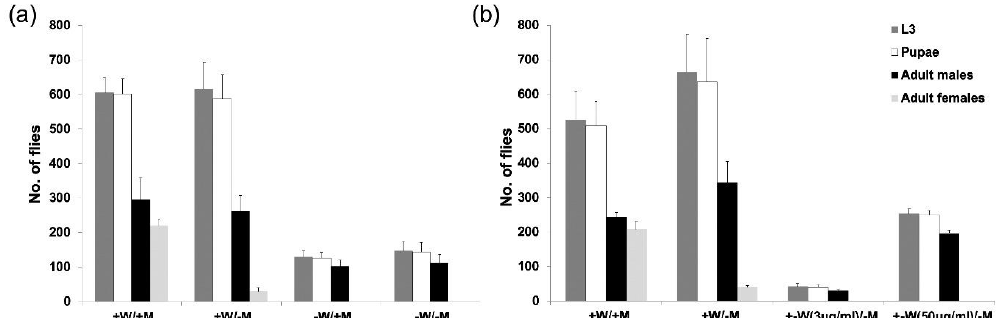
embryos from the constant tetracycline condition (+W, +M), only about half the amount were found on diet without tetracycline (−W, −M) or tetracycline only for the larval diet (−W, +M). This result died at the embryo stage. suggests females died at the embryo stage.